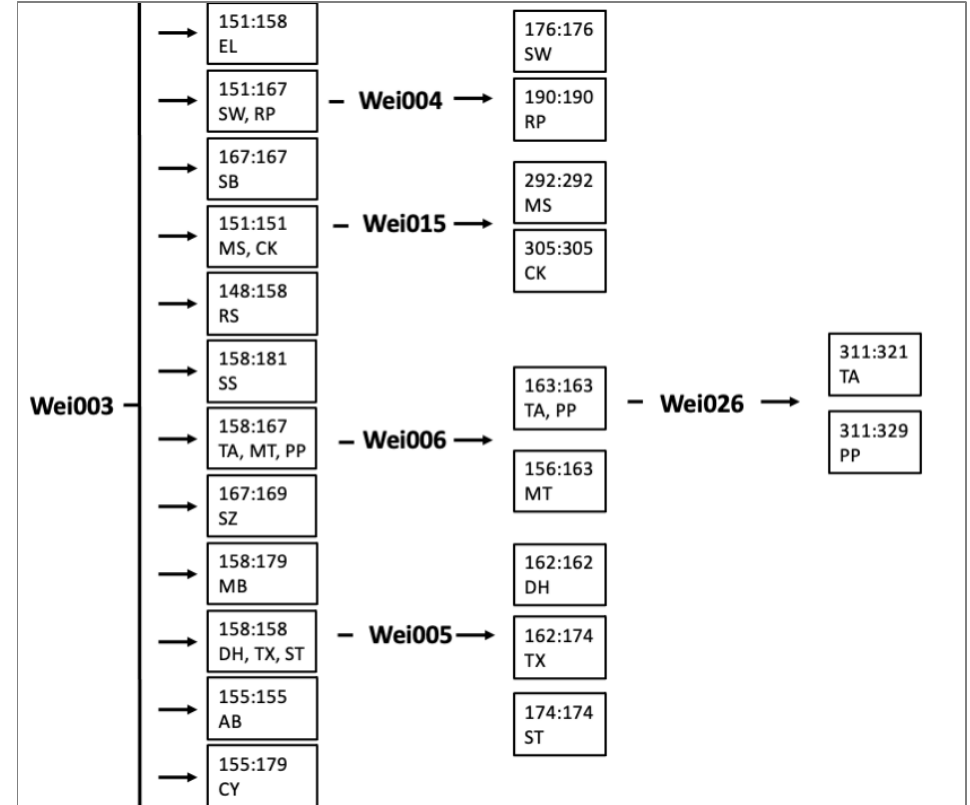
Figure 3. Diagrammatic key to the 18 Weigela cultivars included in this study based on allele size. AB = Towers of Flowers ® Apple Blossom; CK = Crimson Kisses ® ; CY = Towers of Flowers ® Cherry; DH = Dark Horse; EL = Electric Love ® ; MB = Minor Black; MS = Date Night™ Maroon Swoon ® ; MT = Minuet; PP = Pink Poppet; RP = Red Prince; RS = Rainbow Sensation™; SB = Sonic Bloom ® Pink; SS = Shining Sensation™; ST = Stunner™; SW = Spilled Wine ® ; SZ = Suzanne; TA = Tango; TX = Tuxedo™.